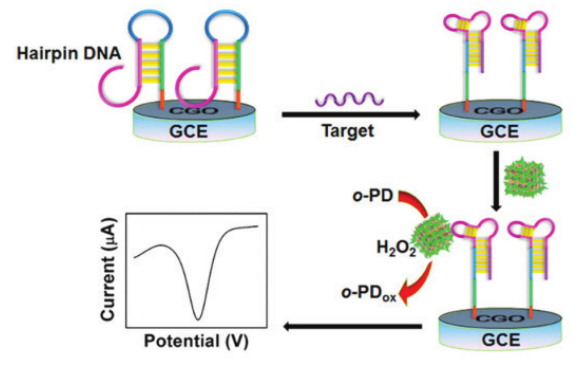
Scheme 8: Schematic representation of electrochemical target DNA detection via Fe(III)TCPP catalysed oxidation of o-PDA by H [116]. Reprinted with permission from Ref. [116]. Copyright © 2015, American Chemical